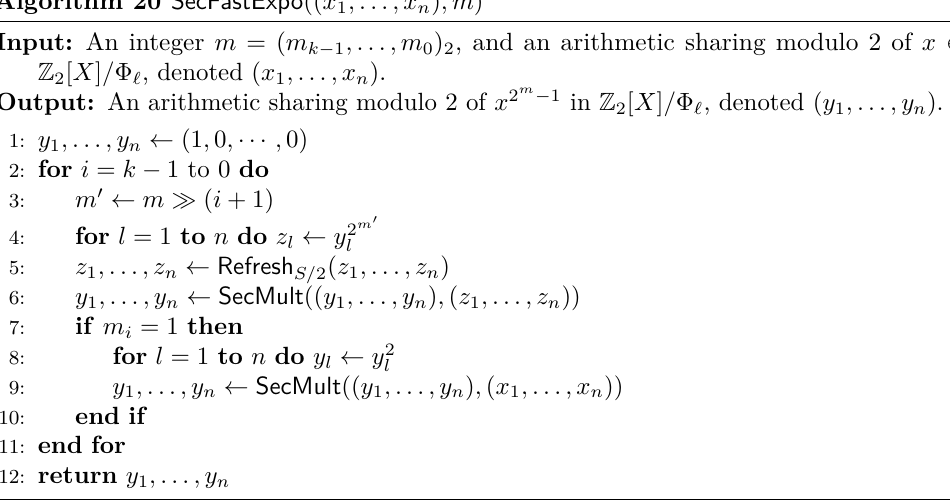
Algorithm 20 SecFastExpo (( x 1 , . . . , x n ) , m )